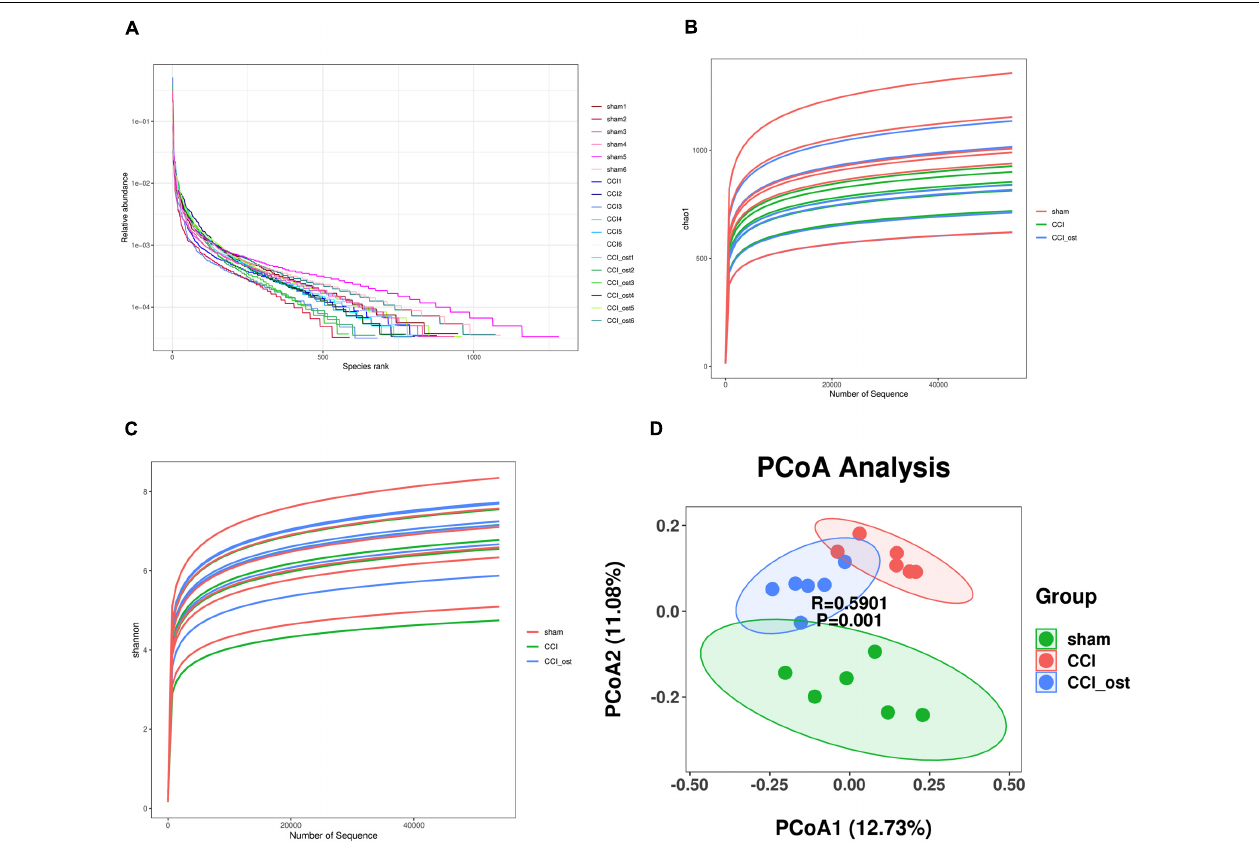
FIGURE 2 | Effects of osthole on the diversity of gut microbiota. (A) The rank abundance curves. (B) The Chao1 indices were used to estimate the diversity of the gut microbiota. (C) The Shannon indices were used to estimate the diversity of the gut microbiota. (D) Principal coordinates analysis (PCoA) diagram illustrating the difference in microbial composition among the three